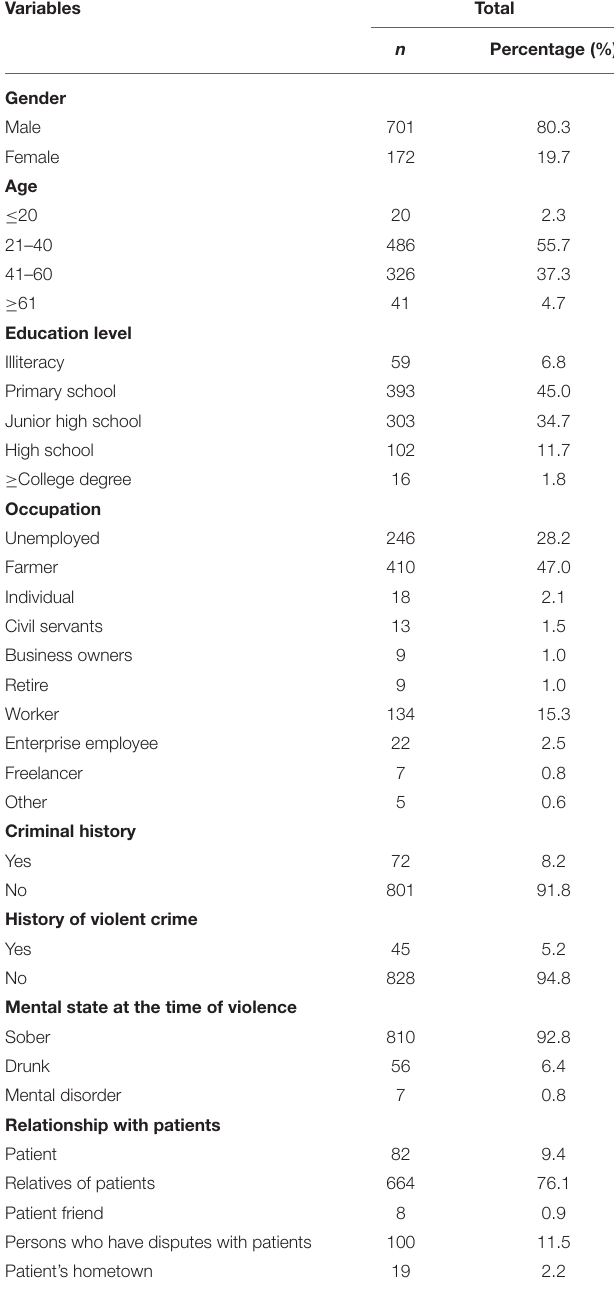
TABLE 1 | Characteristics of